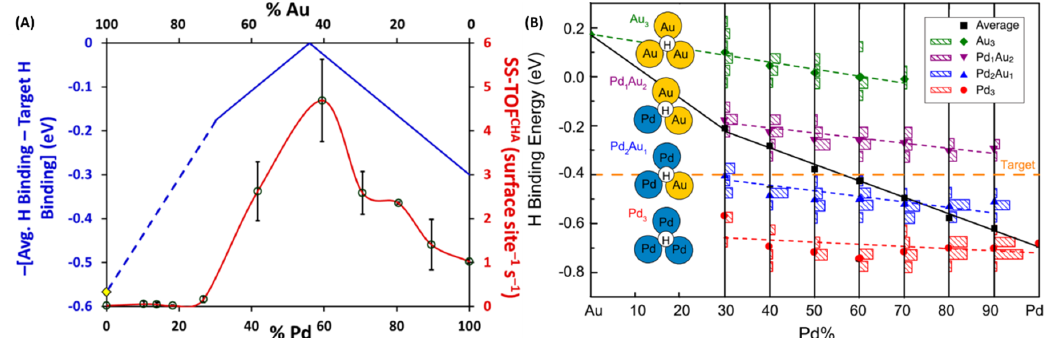
Figure 20. ( A ) Activity trend comparisons between experimental results (red) and theoretical calculations (blue), experimental plot was obtained by plotting SS-TOF for the various Pd x Au 100- x compositions, and the theoretical plot was obtained by calculating the difference in H-binding energies for the different alloyed ensembles and target H binding energy; ( B ) decomposition of average H binding energy into different surface site ensembles, the bars represent the frequency of various binding energies at seven distinct compositions with the average binding energy per site shown as solid symbols. Target H-bonding energy of − 0.4 eV is shown as the orange dashed line. Adapted with permission from the American Chemical Society. Copyright 2016 American Chemical Society.